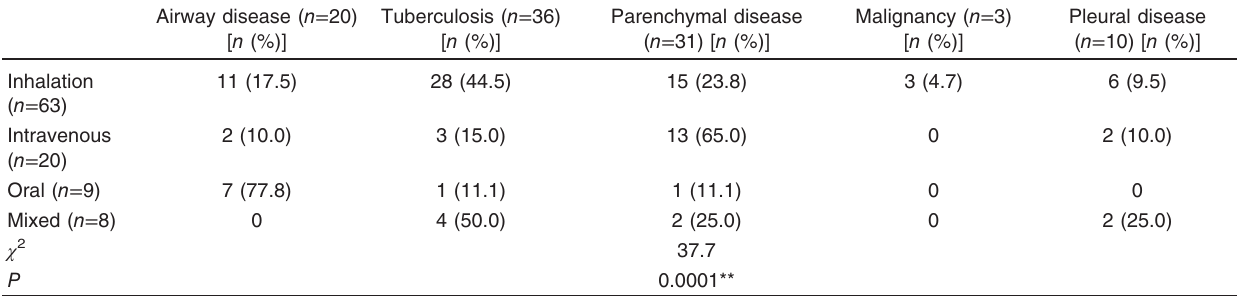
Table 4 Relation between different routes of drug addiction and the pulmonary complications Airway disease ( n =